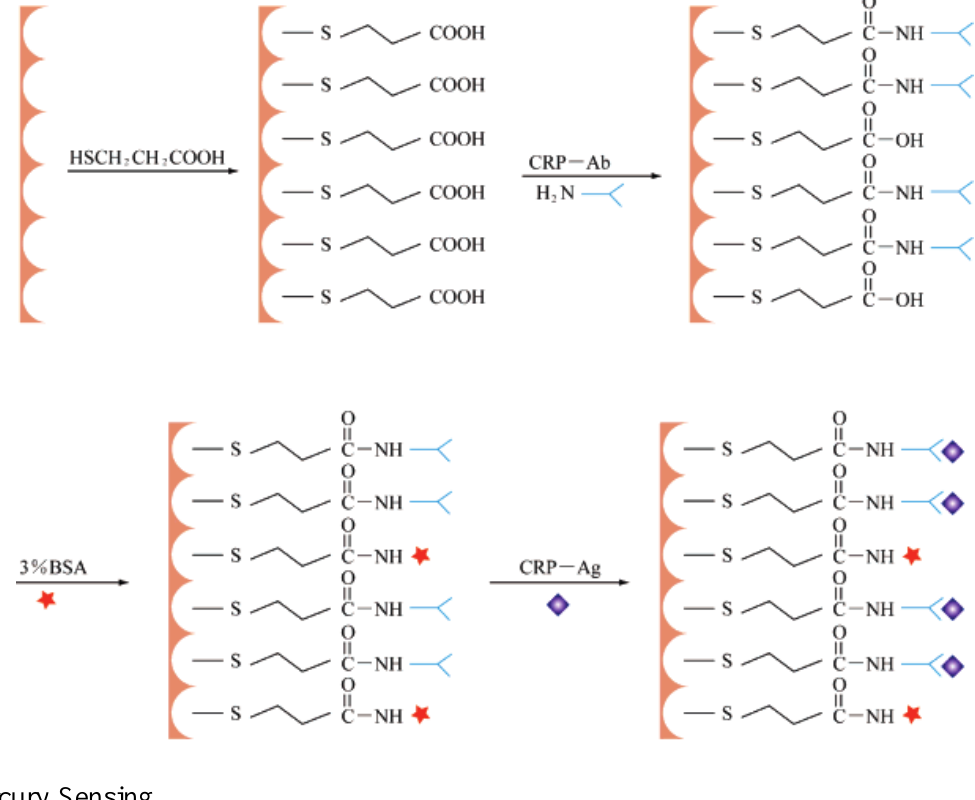
Figure 7. Schematic illustration of the stepwise immunosensor fabrication process. Reprinted with permission from [34]. Copyright 2008, American Chemical